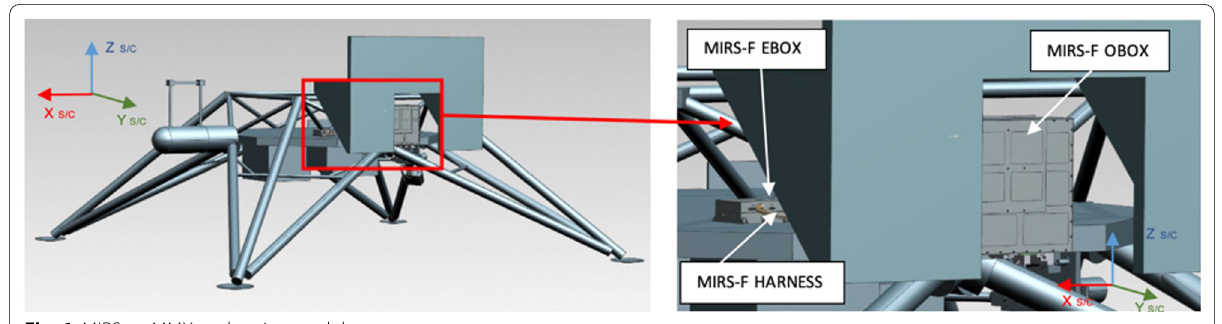
Fig. 6 MIRS on MMX exploration module